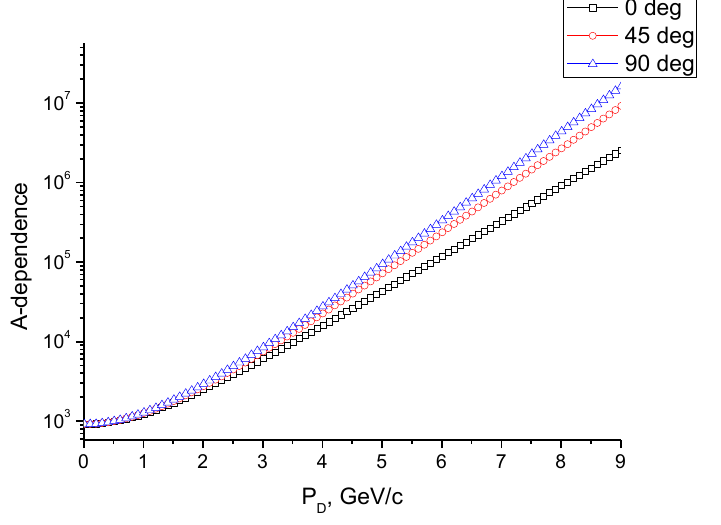
Figure 5. A-dependence of the cross section as a function of particle momentum in Au-Au collisions at 2 GeV/c for 0, 45, and